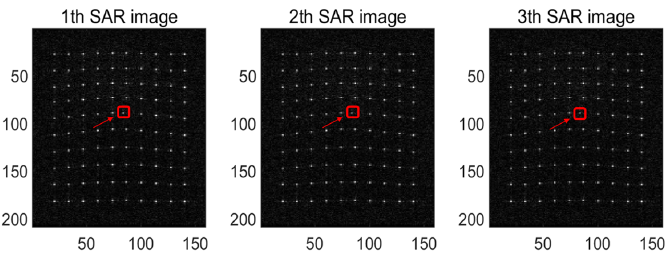
Figure 17. Schematic diagram of the 1st, 2nd, and 3rd in 20 SAR images ( v x = 0.1 m/s).